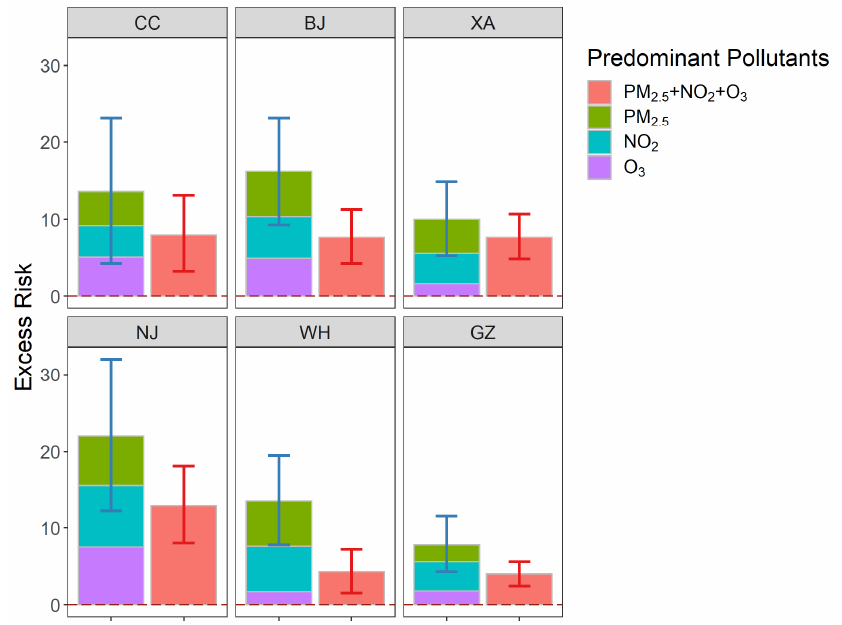
Figure 3. Comparison of the simple sum of the excess risks (95% CIs) of individual pollutants (PM 2.5 , NO 2 , and O 3 ) at high levels (left) with the excess risks (95% CIs) of the multi-pollutant air pollution type with all three pollutants are simultaneously at high levels (right).